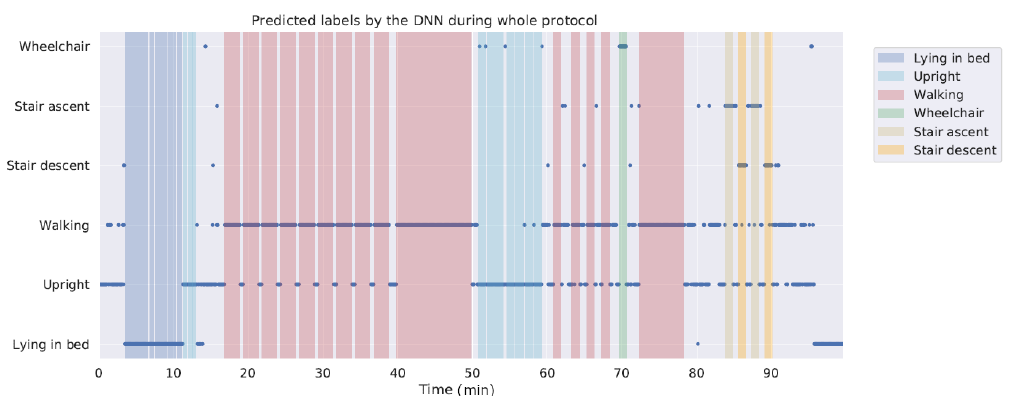
Figure 6. Predictions of the deep neural network (DNN) when the whole recording session of one subject is passed into the model. The grey areas represent unlabelled activities, which were not included when training the